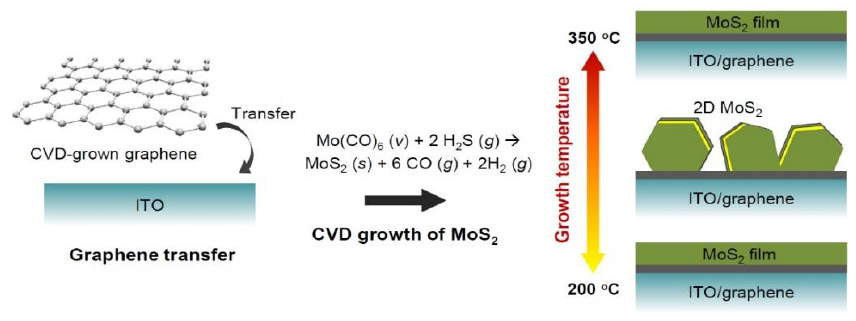
Figure 1. Schematic of the preparation method for various MoS 2 nanostructures on graphene.